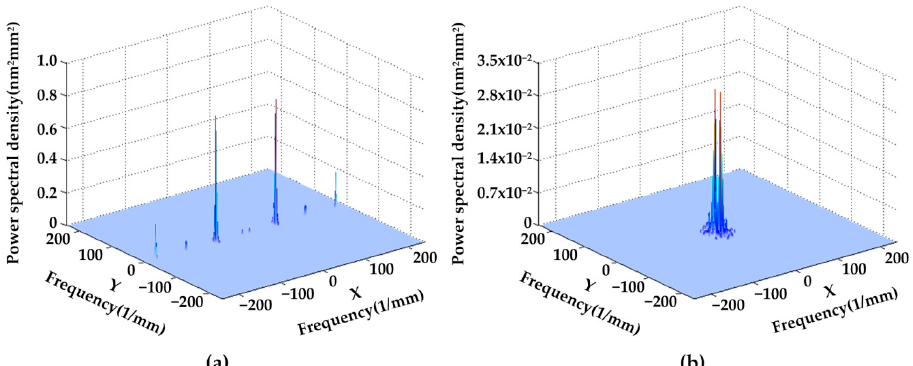
Figure 5. 2D-PSD comparison ( a ) SPDT machined surface (distribution along X frequency with maximum value of 0.7 nm 2 mm 2 ) ( b ) WDUP machined surface (higher concentration of low spatial frequency with maximum value of 2.8 × 10 − 2 nm 2 mm 2 ).